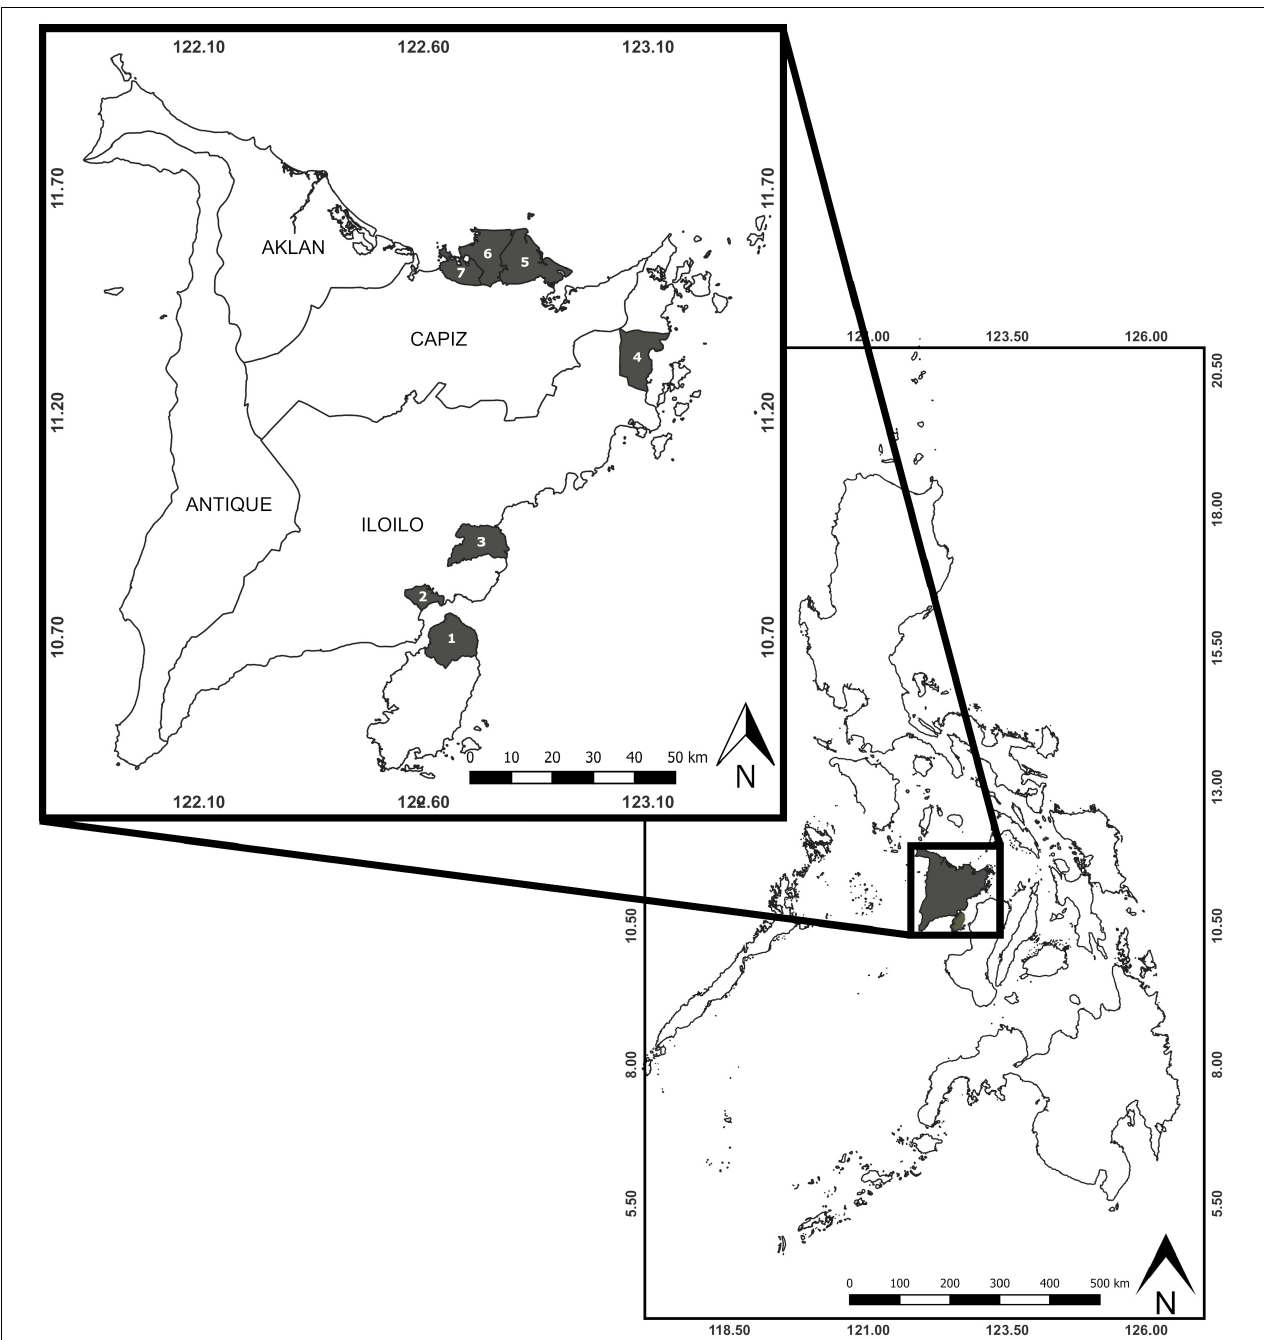
FIGURE 1 | Locations of municipalities with abandoned aquaculture ponds examined within this study, within Iloilo and Capiz Provinces, West Visayas, Philippines. (1) Buenavista, Guimaras, Iloilo [ n = 1 naturally-regenerating (NR) abandoned aquaculture pond]; (2) Leganes, Iloilo [ n = 1 NR and n = 1 assisted naturally-regenerating (ANR; planted) abandoned pond]; (3) Barotac Nuevo, Iloilo ( n = 1 NR abandoned pond); (4) San Dionisio, Iloilo ( n = 1 NR abandoned pond); (5) Panay, Capiz ( n = 1 NR abandoned pond); (6) Roxas City, Capiz ( n = 1 NR abandoned pond), and; (7) Ivisan, Capiz ( n = 1 NR abandoned pond).